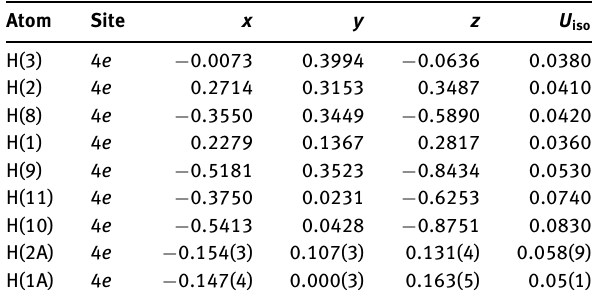
including atomic coordinates and displacement parameters.